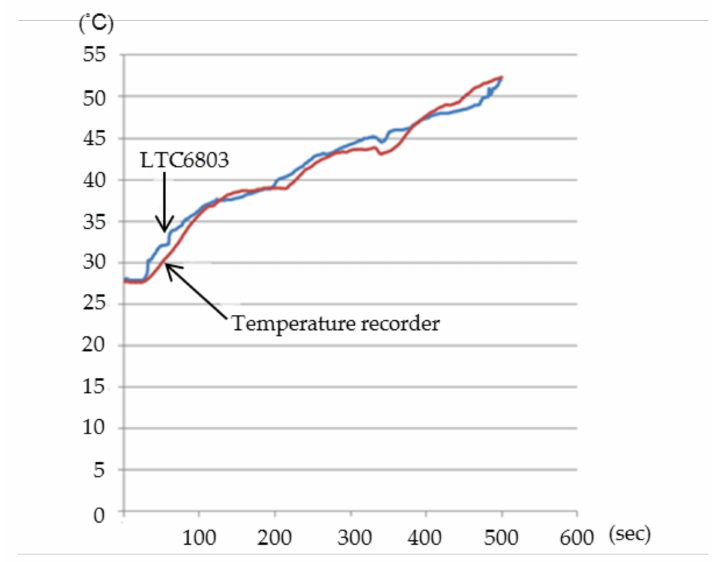
Figure 15. Temperature measurement curves of LTC6803 and temperature